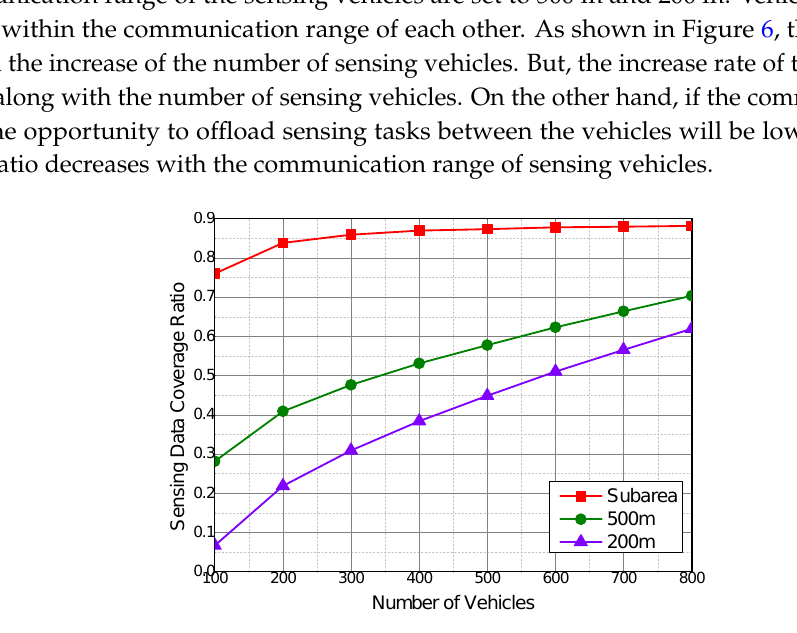
Figure 6. Sensing data coverage ratio with more sensing vehicles.